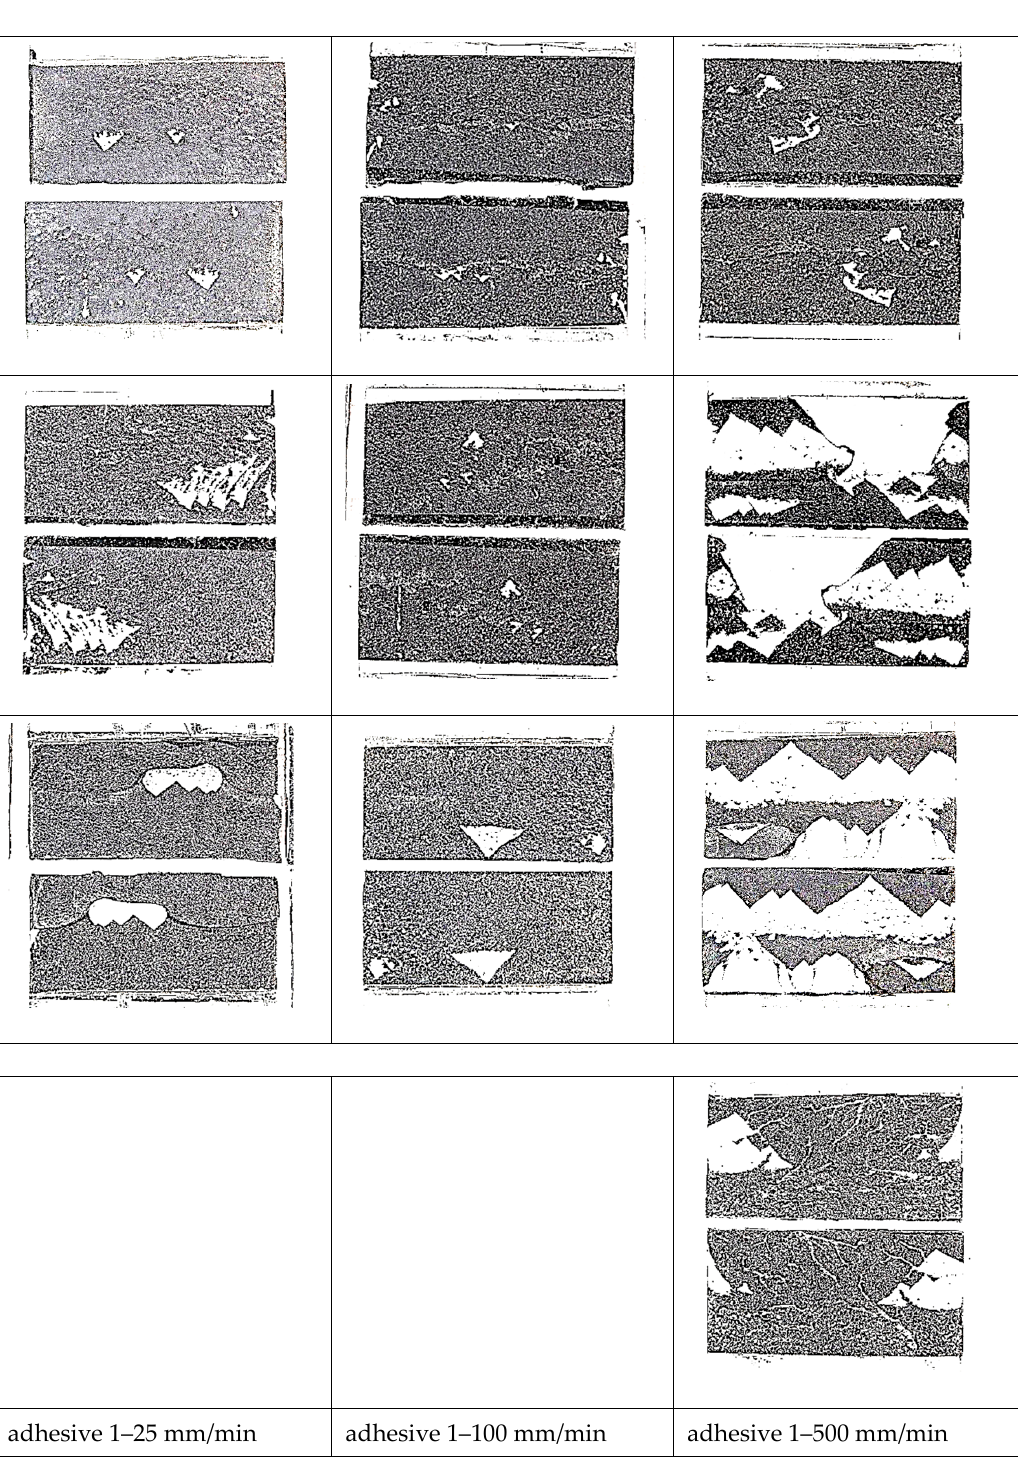
Figure 28. Failure surfaces of single lap joints bonded with adhesive 1 shown in pairs (both sides of the joint), tested at different extension rates.